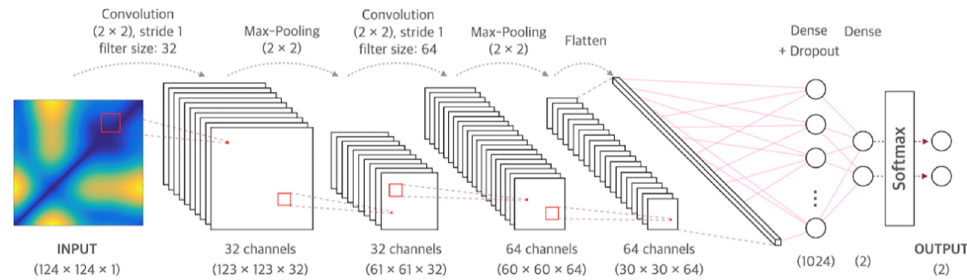
Figure 1. Architecture of the convolutional neural network used in this study.